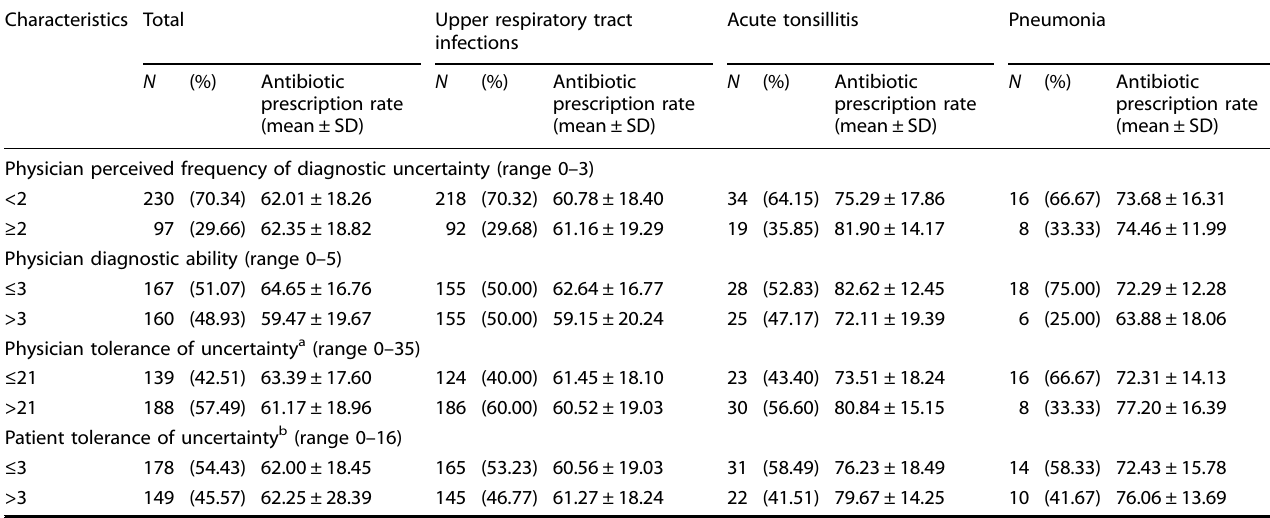
Table 1. Antibiotic prescription rates in primary care physicians with different levels of factors relevant to diagnostic uncertainty. Characteristics